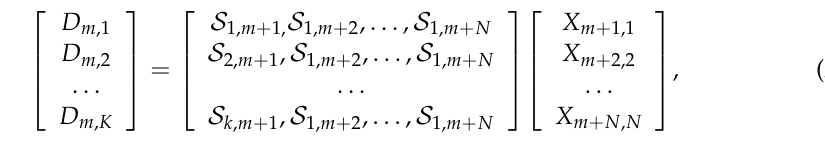
Figure 2. The imaging process of various hyperspectral imaging systems. The system with uniform slits exhibits a higher imaging speed compared with a scanning-based spectrometer. Additionally, the system with coded slits exhibits a higher SNR with respect to the system with uniform slits, as is illustrated in Section 2.2. In the reconstruction process of a system with coded slits, we extract the measurement matrix S m from coding matrix S and apply matrix inversion to the measurements to reconstruct a spatially shifted spectral vector. The details of this process are given in Section 2.1.